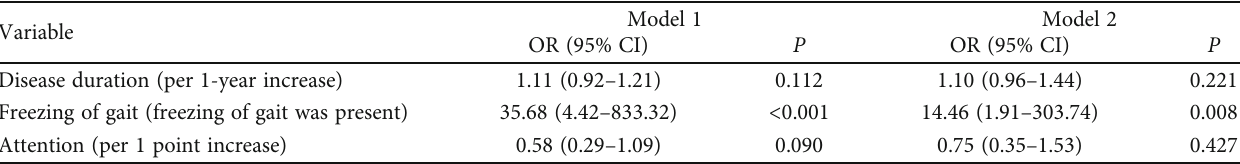
Table 2: Logistic regression analysis to assess driving